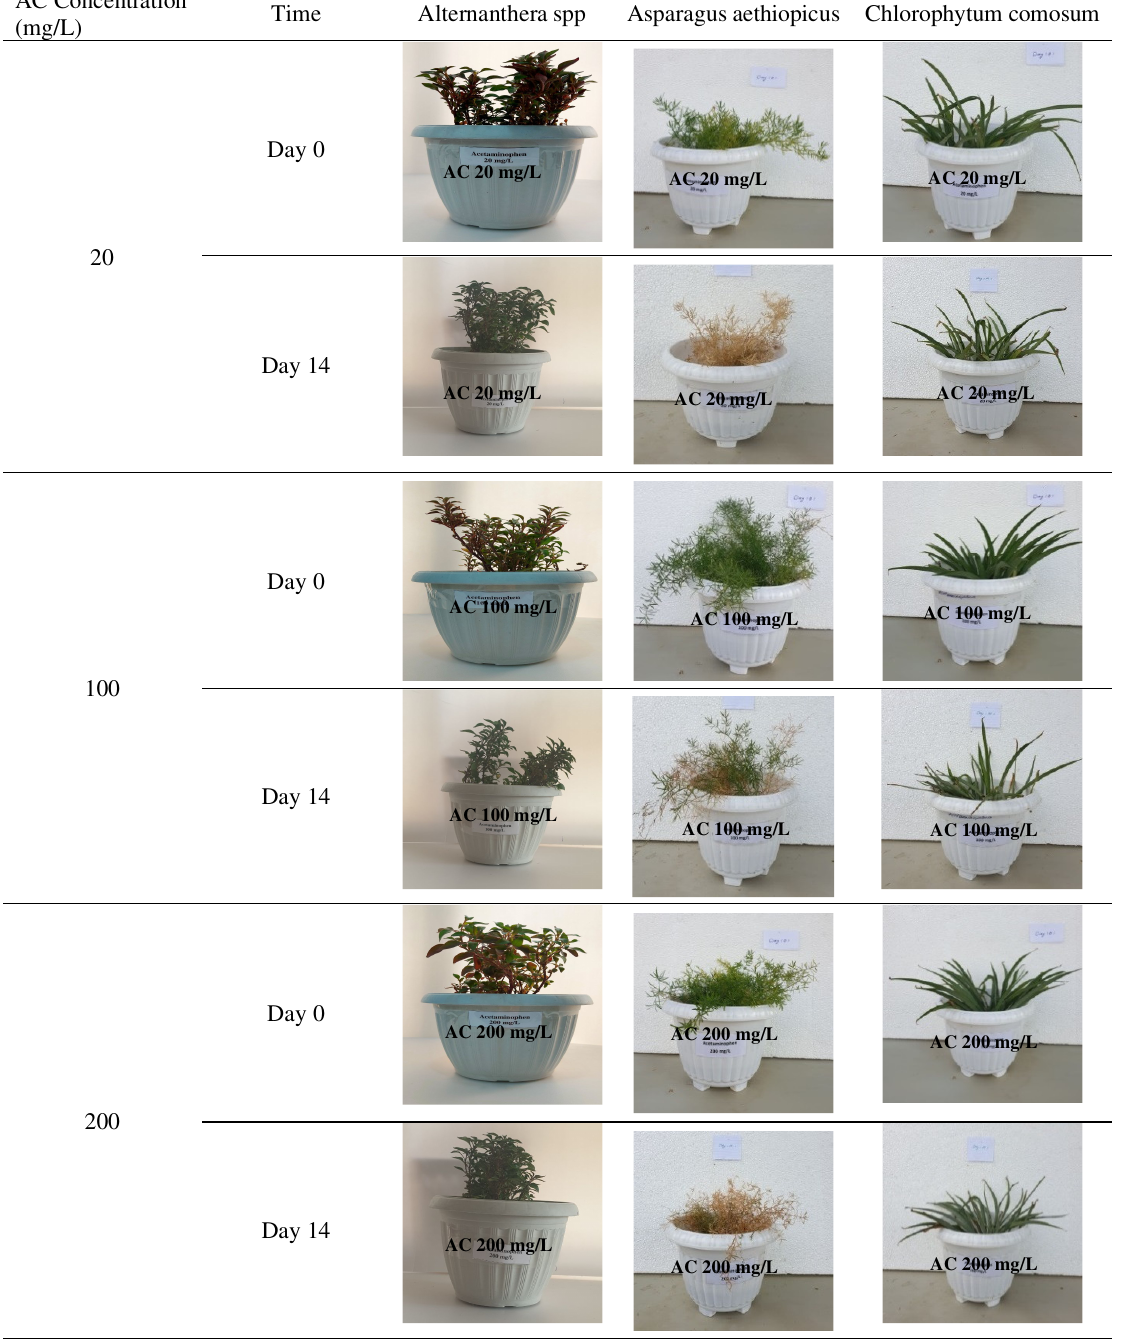
Table 3, The physical appearance of selected plants in acetaminophen-exposed systems AC Concentration